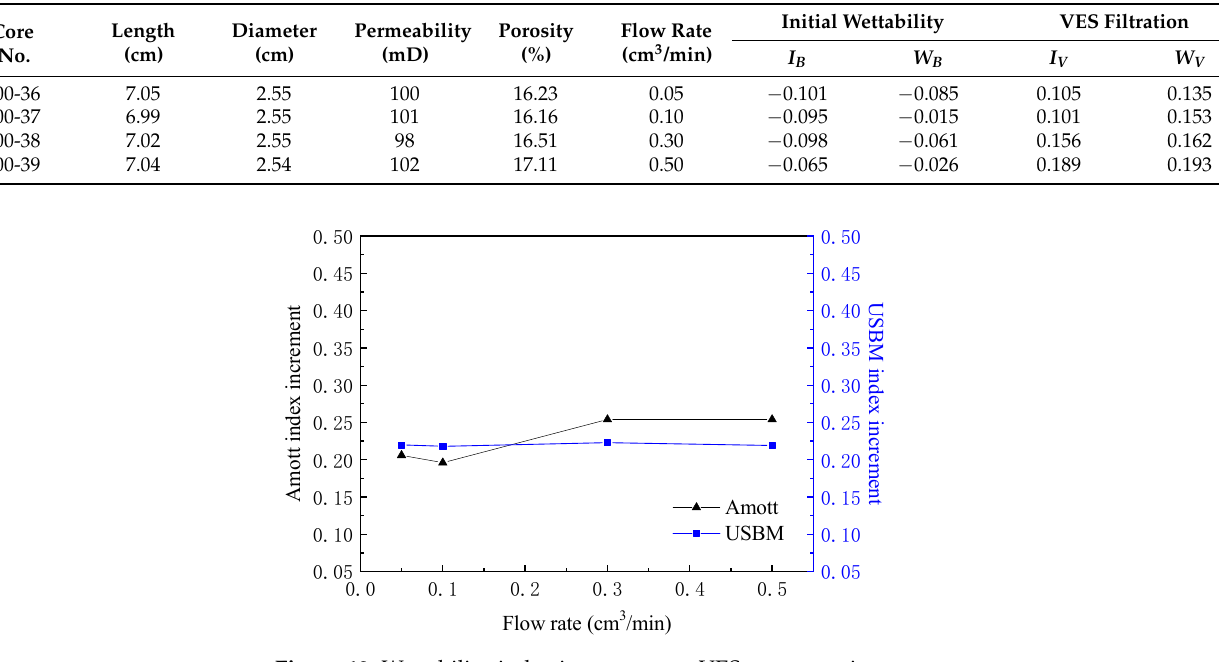
Figure 10. Wettability-index increment vs. VES concentration.